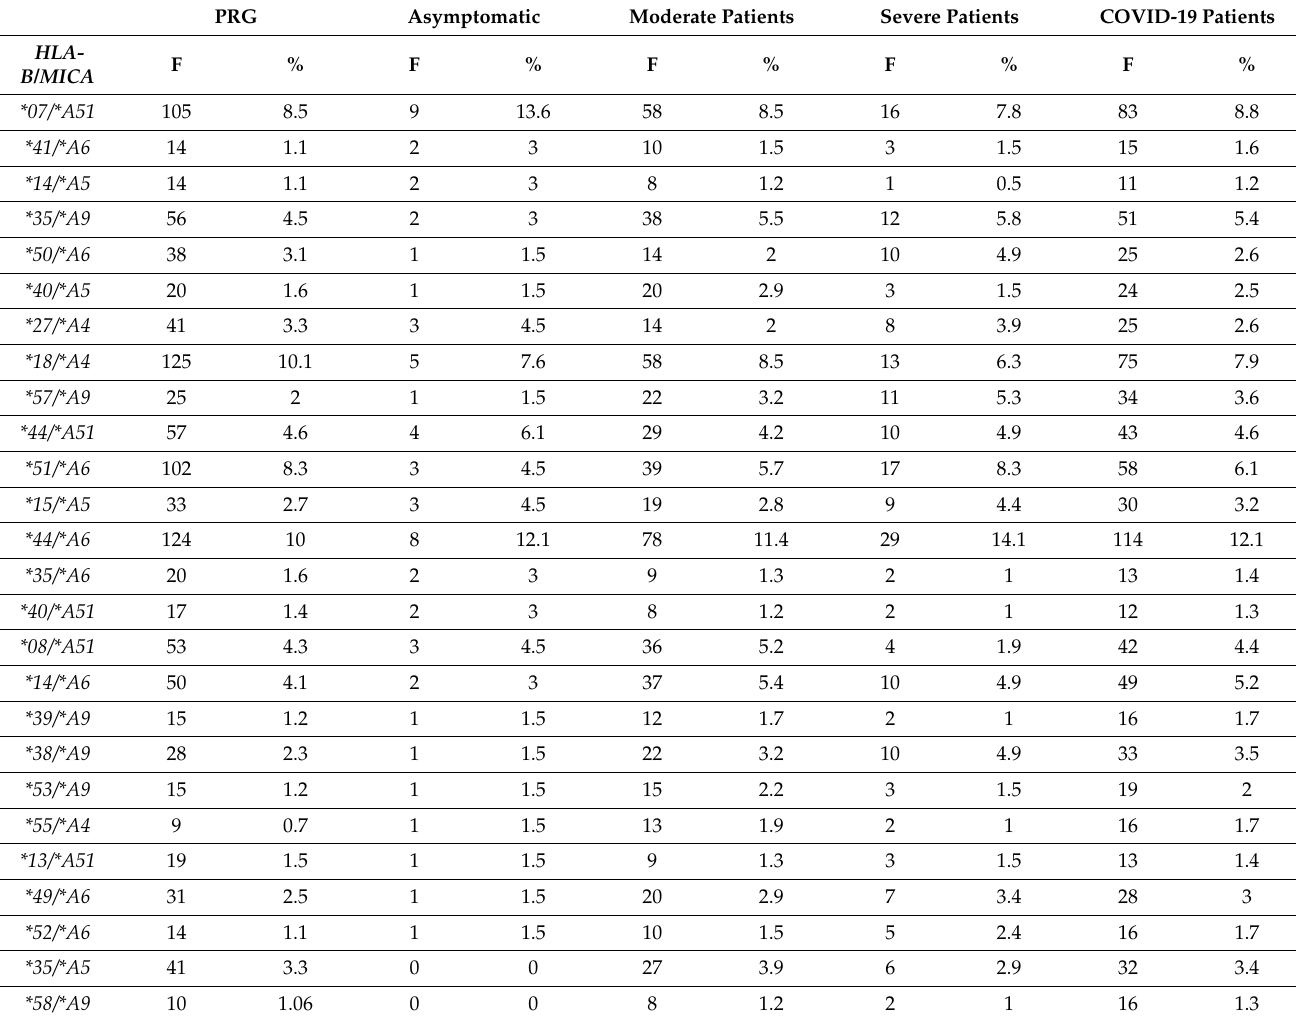
Table 2. HLA-B/MICA haplotype